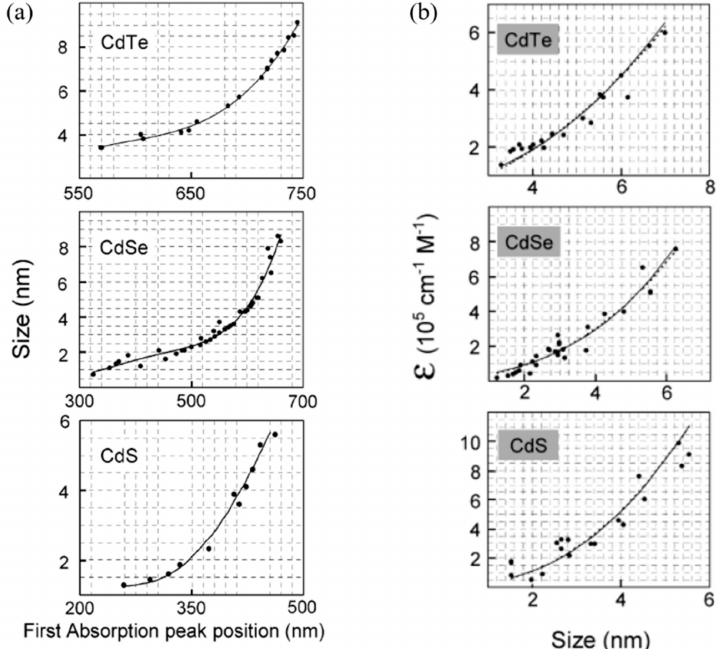
Figure 6. ( a ) Size curves vs. the first absorption peak position; ( b ) size-dependent molar absorption coefficients of nanocrystals at the first excitonic absorption. Reprinted with permission from [47]. Copyright 2003, American Chemical